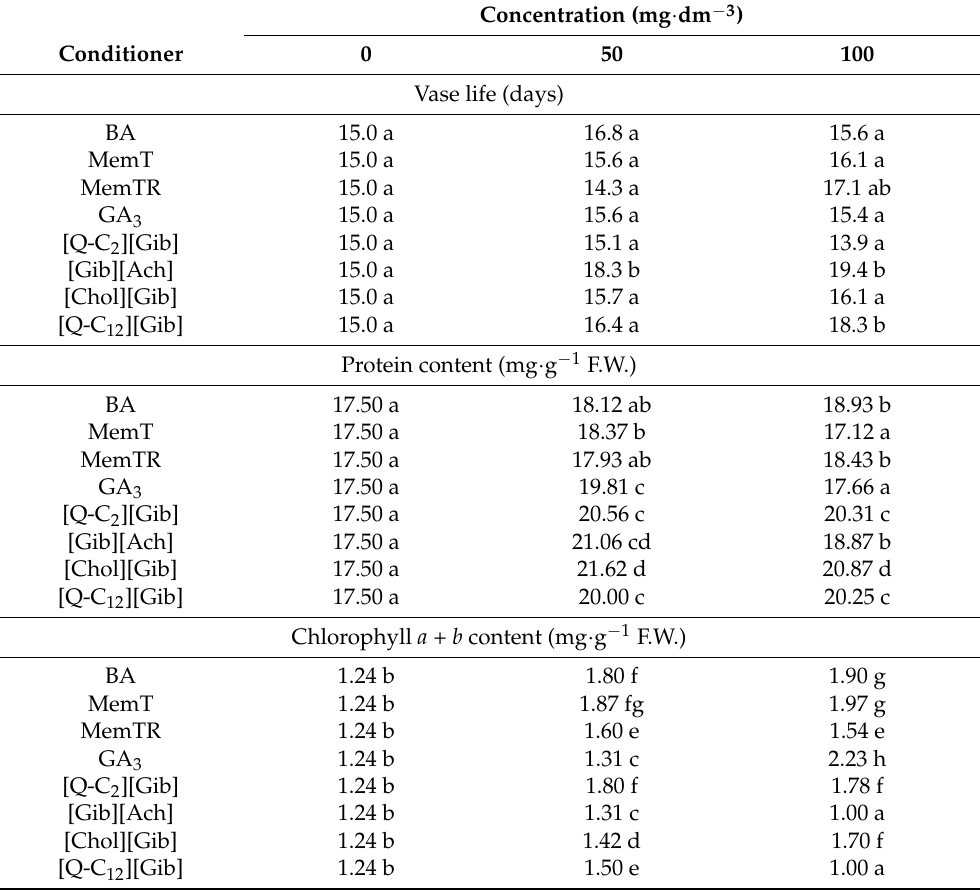
Table 3. Vase life (days) of leaves, protein, and chlorophyll a + b content (mg · g − 1 F.W.) in leaves of Limonium latifolium depending on conditioner type and concentration. Means followed by the same letter column-wise and row-wise do not differ significantly at α =